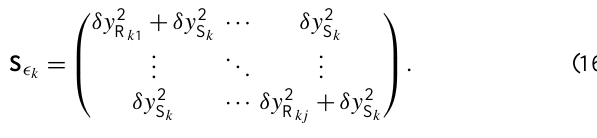
Fig. 8. Averaging kernels for the simulated extinction and mode radius retrievals using lines of sight spaced at 1km intervals. Left panel shows the extinction averaging kernels with the mode radius averaging kernels shown on the right. The black line shows the vertical resolution calculated from the full-width half-max of the averaging kernels.